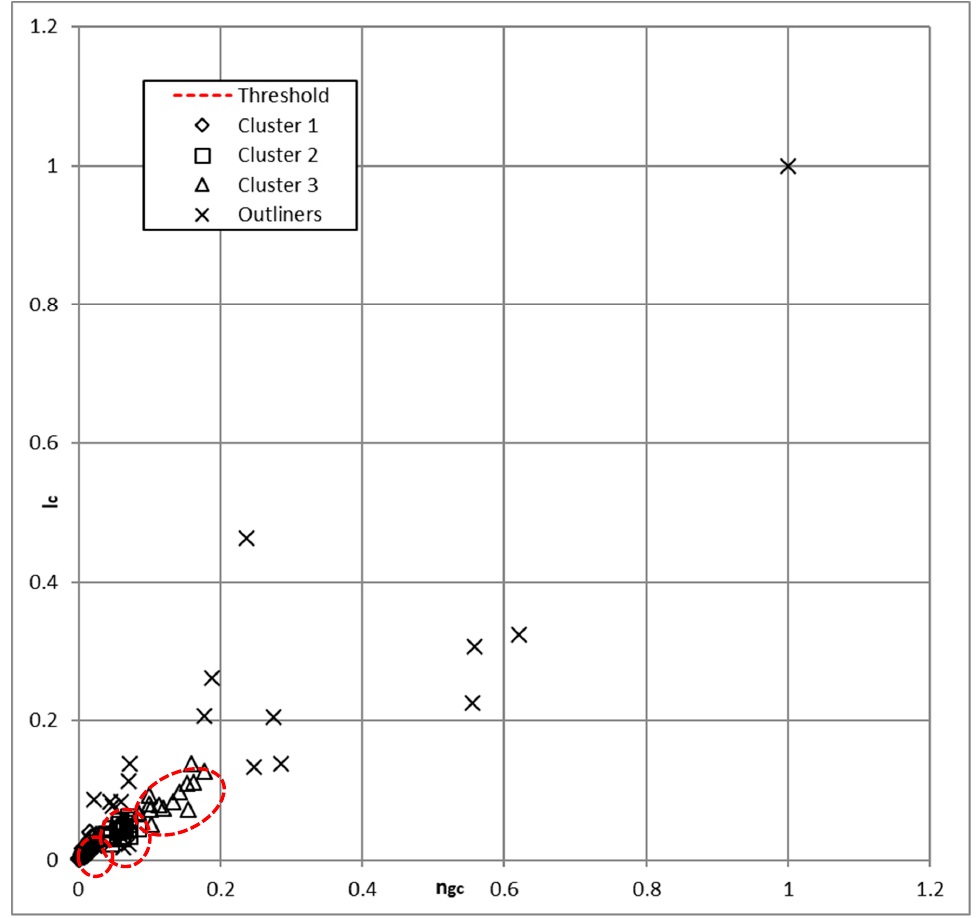
Figure 9. Clustering obtained with the DBSCAN algorithm for attributes l c,N and N gc,N , n min = 5 and ε = 0.0075). ε =